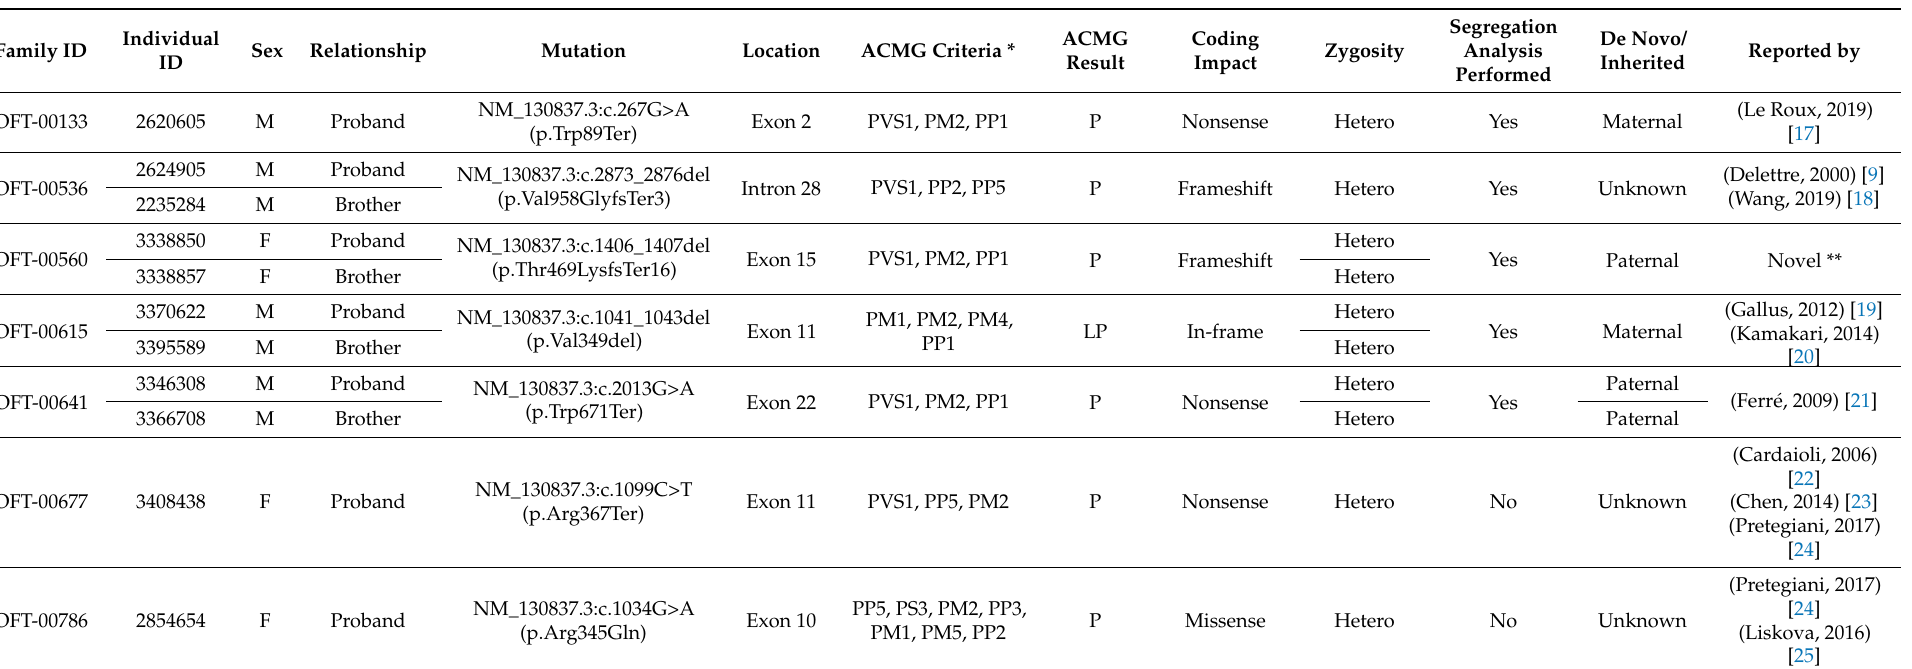
Table 2. Genetic results of the probands for the OPA1 gene according to OPA1 transcript variant 8 (RefSeq: NM_130837.3) representing the longest